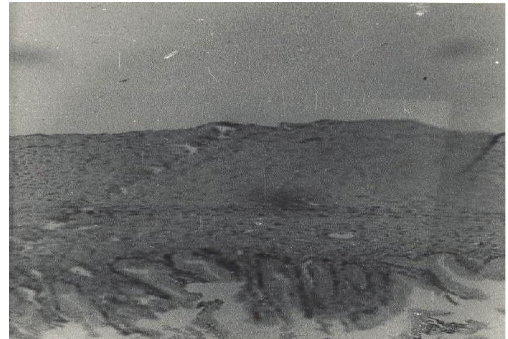
Figure 10: Plate of photomicrograph of intestine of Clarias gariepinus after 12 weeks showed no yellow bodies.